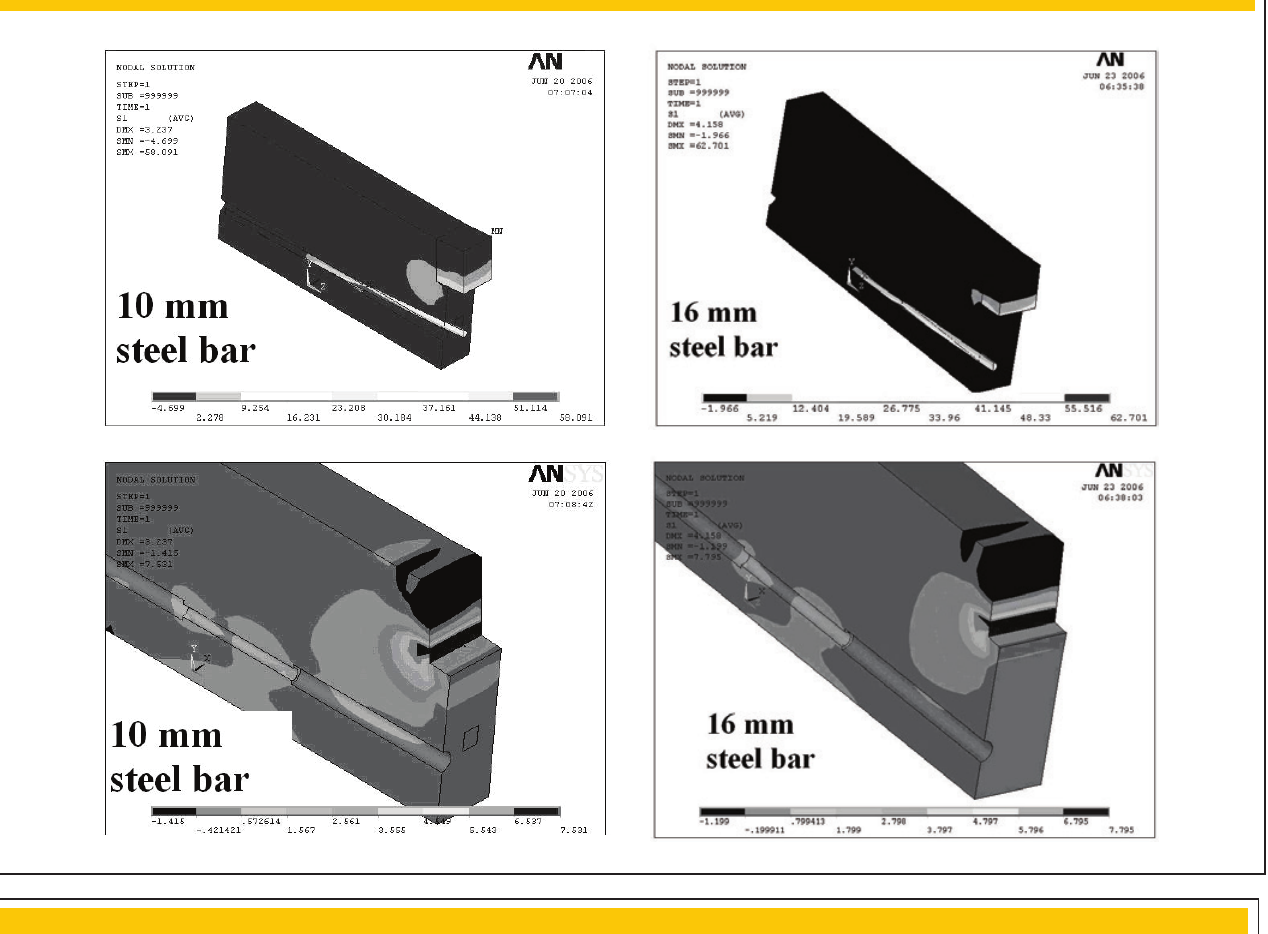
Figure 16 – Principal stresses of the numerical beam models